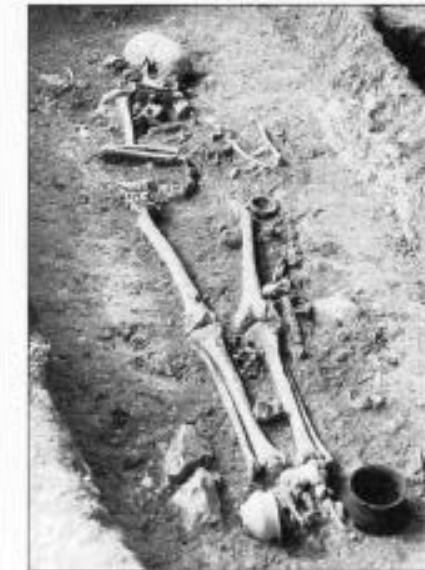
Figure 4 An excavated single adult bur­ ial accompanied by various grave goods including, beside the feet, wheel-thrown pottery vessels of Merovingian age, Longroy cemetery, 1